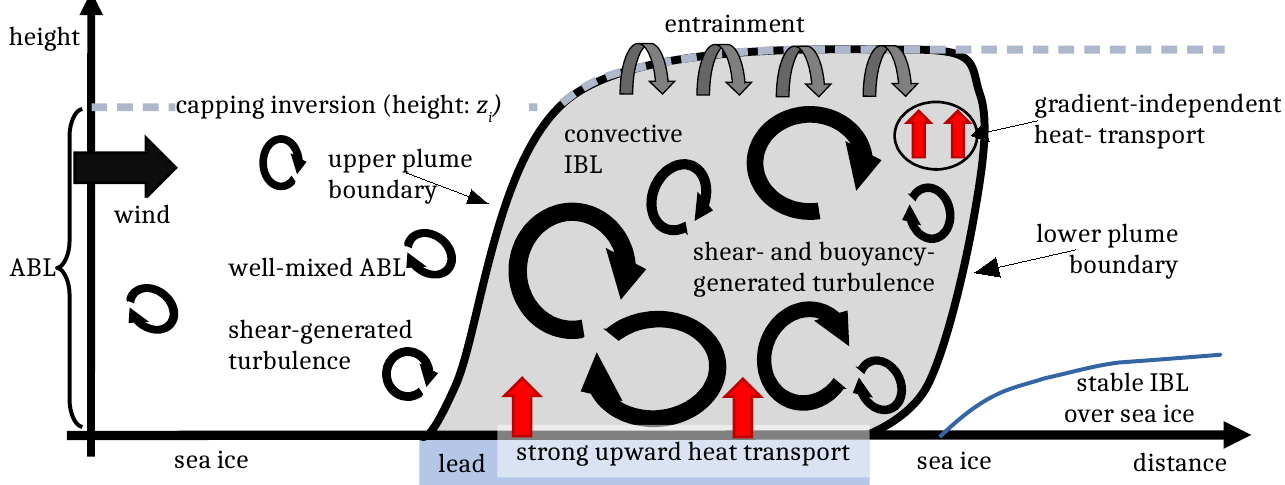
Figure 1. Sketch of the atmospheric boundary layer (ABL) over a lead in sea ice for a lead- perpendicular flow. Effects of the lead on the ABL are shown. They are caused by enhanced turbulence due to a strong upward convective heat transport over the lead. A convective internal boundary layer (IBL) is formed, also referred to as convective plume, and a stable IBL is generated over the downwind sea ice. The upwind ABL of height z i is capped by a strong inversion, and pene- trating convection may cause downward transport of heat through this layer (vertical